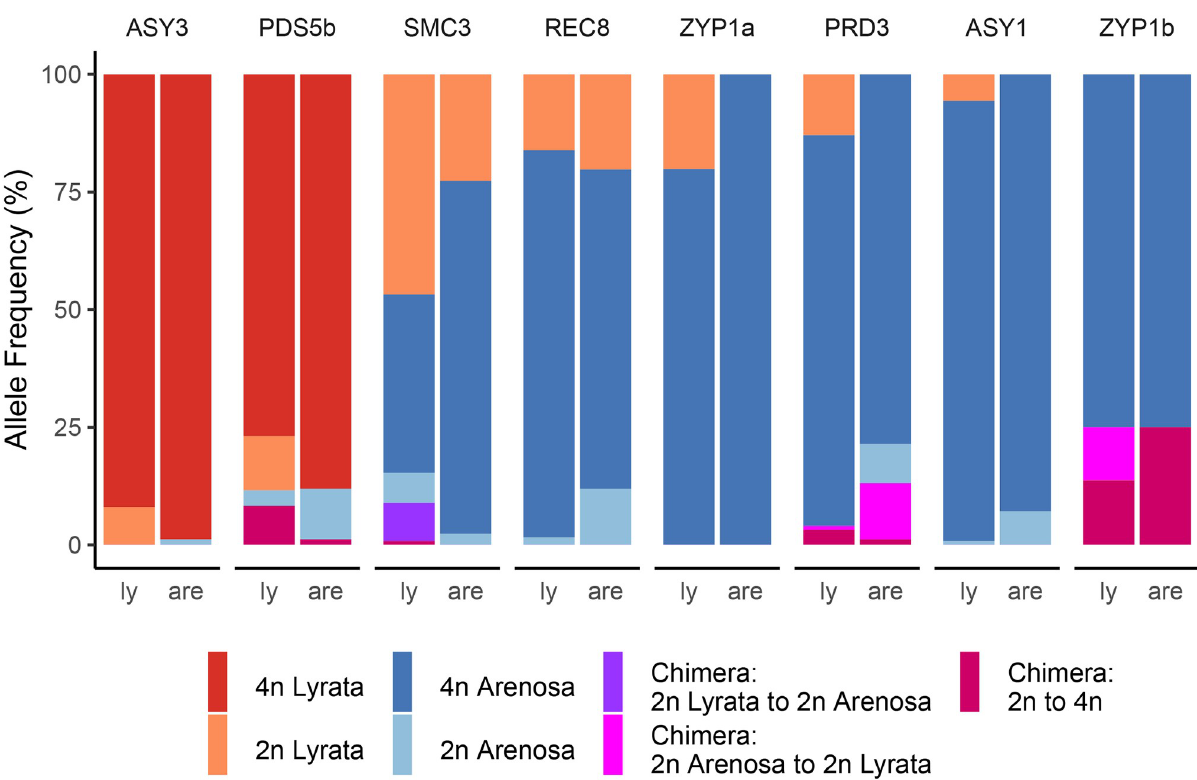
Fig 5. Contrasting origins and polymorphisms of adaptive meiosis gene haplotypes in tetraploid introgressants of A . lyrata / A . arenosa . Haplotype frequencies of adaptive meiosis alleles from A . lyrata ( Ly ) and A . arenosa ( Ar ) populations.